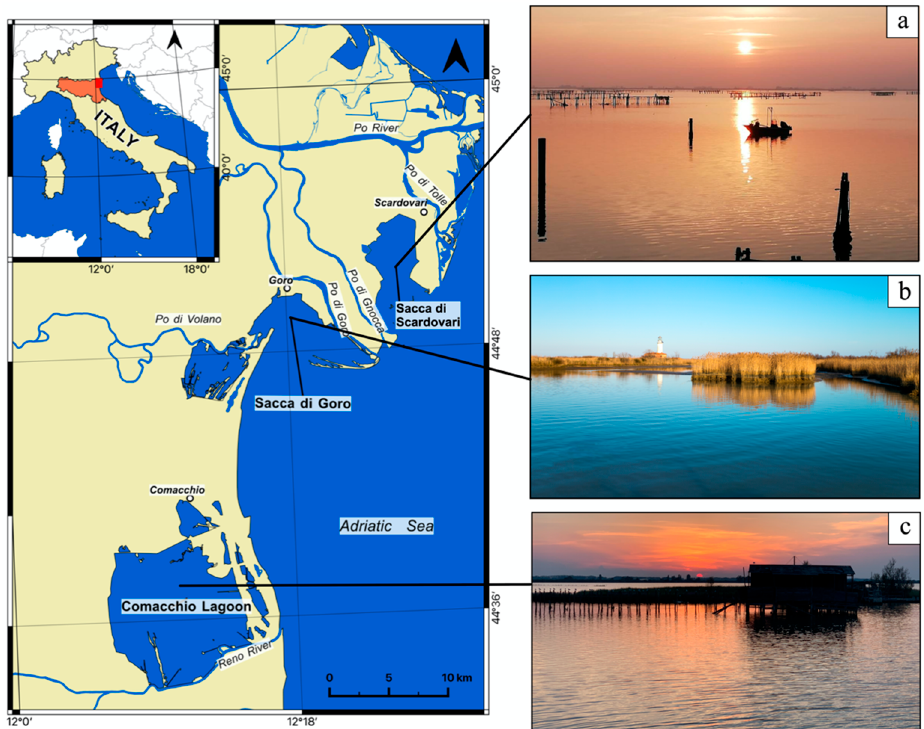
Figure 1. Geographic setting and locations of the investigated northern Adriatic lagoons within the Po River delta area in Italy. Photos of ( a ) Sacca di Goro; ( b ) Sacca di Scardovari; and ( c ) the Comacchio Lagoon.